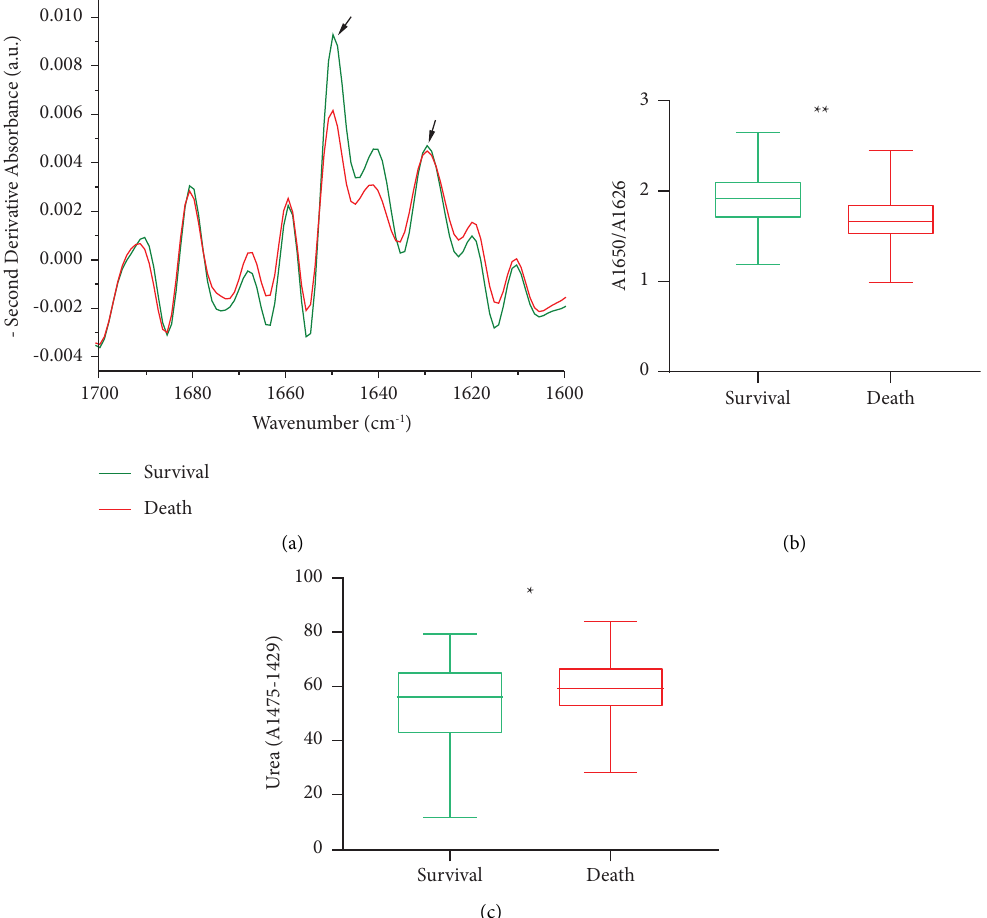
Figure 3: Proteins region analysis on hospitalized patients with severe COVID-19 who survived or died. (a) Second derivative of the ATR- FTIR spectra in the amide I region. (b) Alpha helix/ β -sheets (median and RIQ) area ratio. (c) Urea peak (median and RIQ). U- Mann–Whitney analysis. ∗ p < 0 . 05, ∗∗ p < 0 .